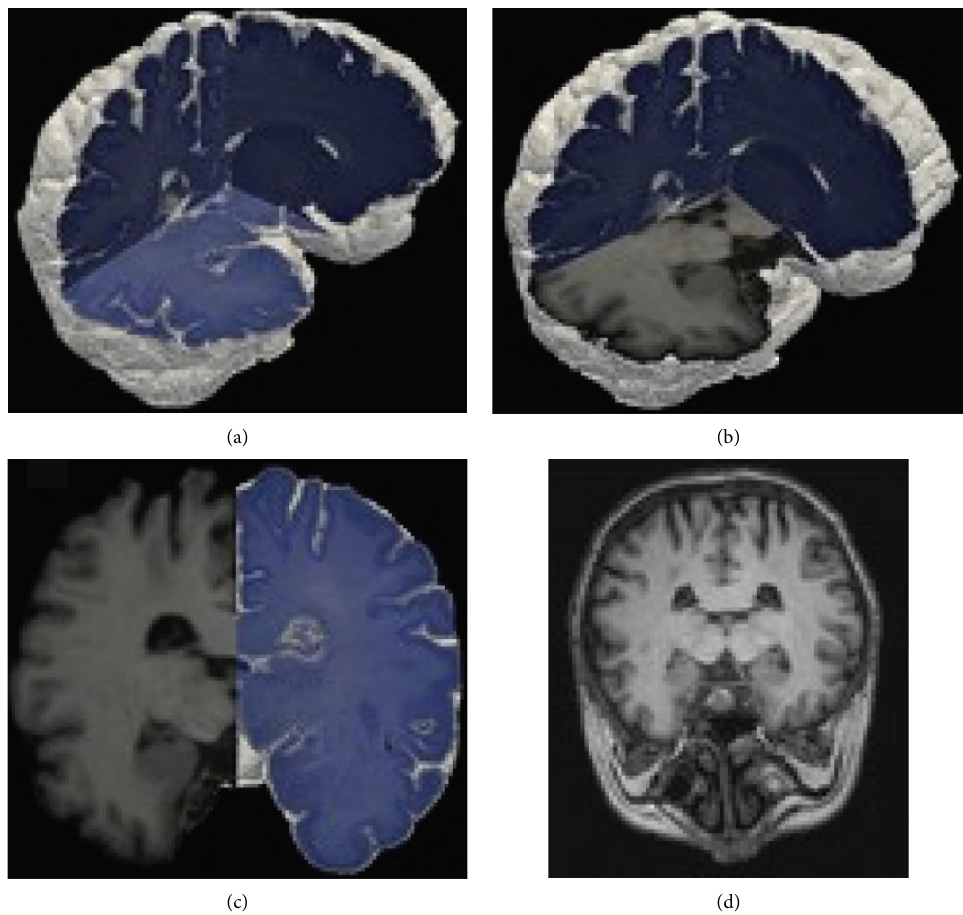
Figure 11: Comparison of the reconstructed three-dimensional histology with the MRI volume of a whole postmortem human brain [46]. Te complete reconstruction of the histology volume (a). (b, c) Te correlation of both modalities. A reference of the MRI (d).